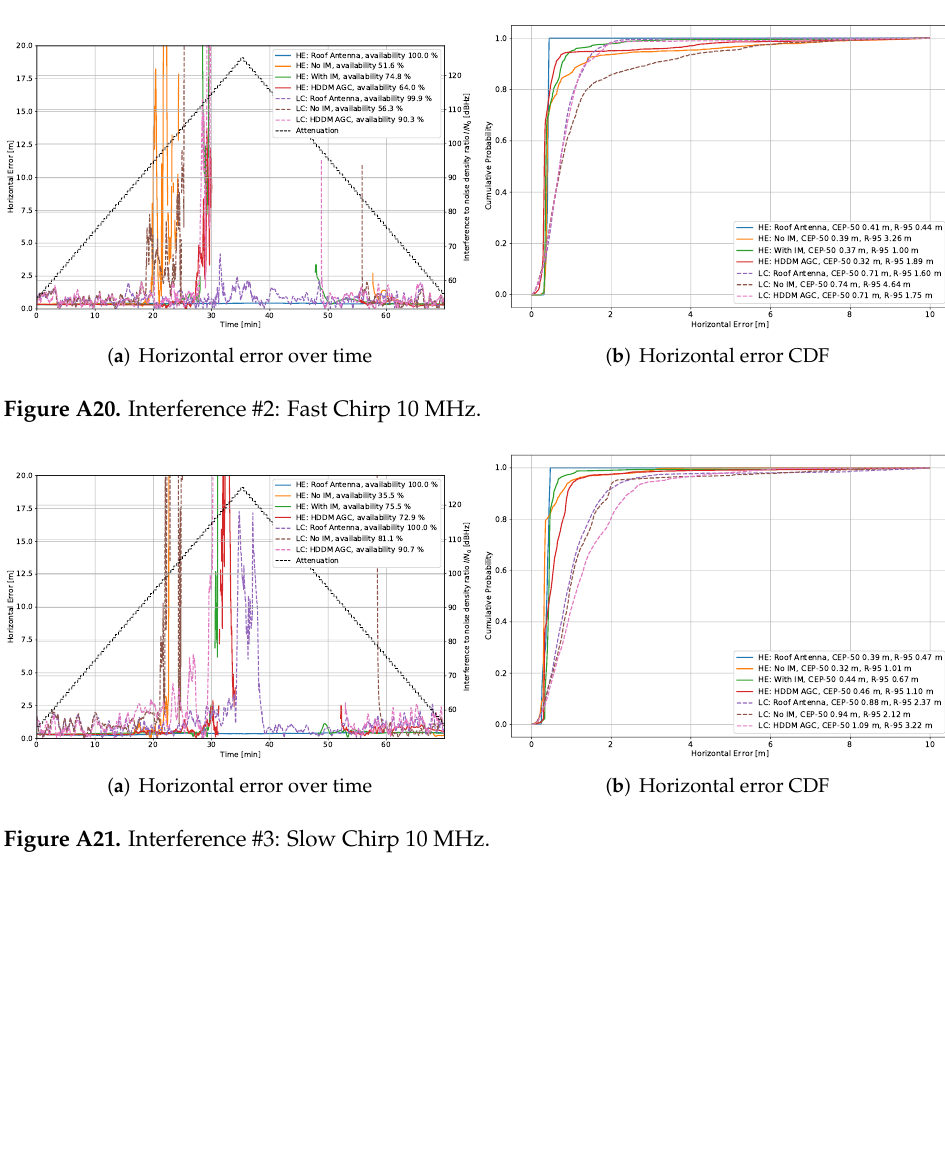
Figure A19. Interference #1: CW 1 575.42 MHz.